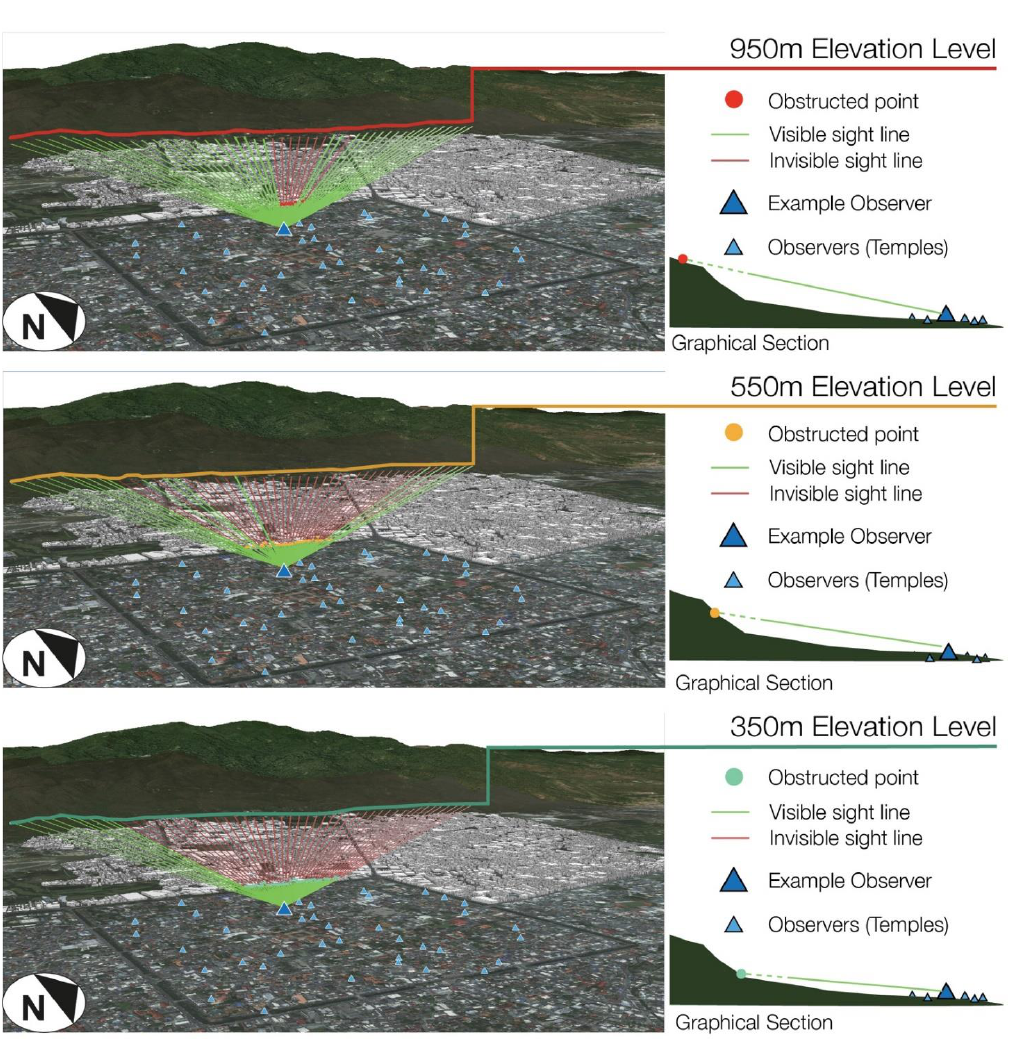
Figure 8. Mountain skyline obstruction analysis (Source: Authors).